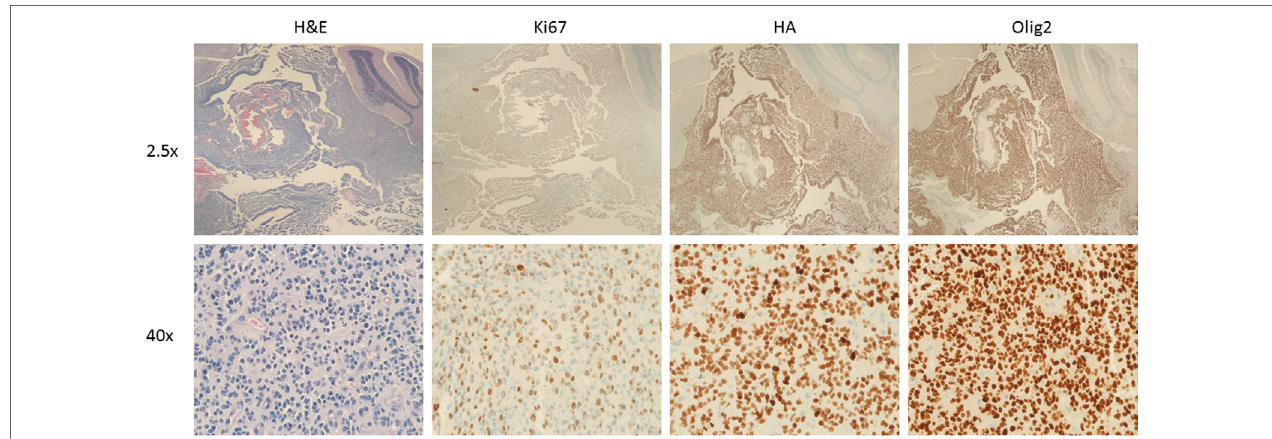
FiGURe 2 | Murine diffuse intrinsic pontine glioma (DIPG) induced by PDGF-A; H3.1K27M; p53 loss. Low (top) and high (bottom) magnification images of a murine DIPG induced with the RCAS/tumor virus A (TVA) system using Nestin TVA; p53 floxed/floxed mice. Neonatal mouse was infected postnatally with DF1 expressing RCAS vectors expressing PDGF-A, H3.1 K27M, and Cre (to delete p53) at a ratio of 1:1:1, and euthanized 43 days’ post-infection. Images from left to right: H&E, Ki-67, HA (tag for H3.1K27M), and Olig2 immunohistochemistry. Note the infiltration into the cerebellum (best seen on low magnification HA and Olig2 immunohistochemistry